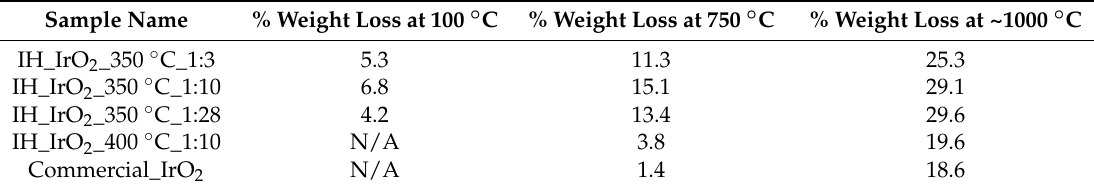
Table 2. Percentage weight loss during thermal gravimetric analysis (TGA).